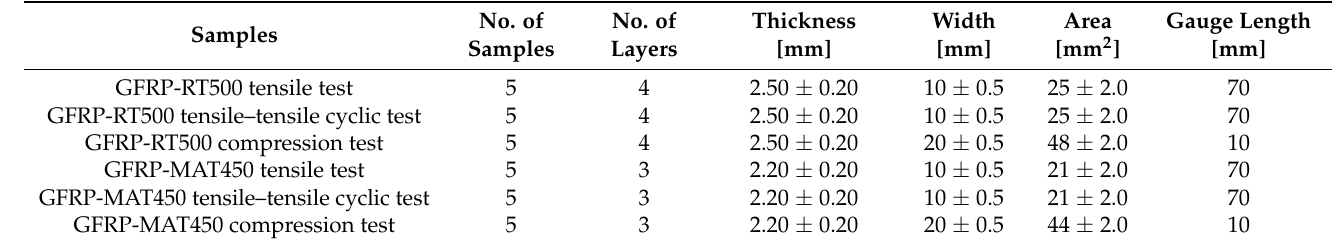
Table 1. The physical characteristics of samples.